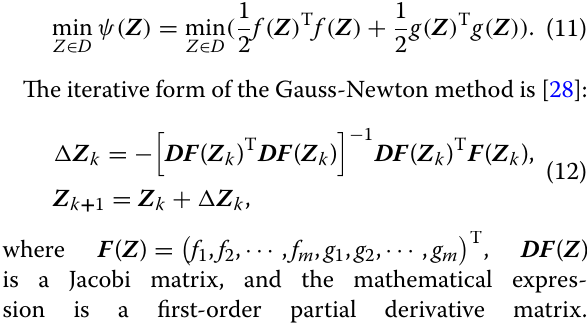
a) Determine the initial crack tip position ( x o , y o )